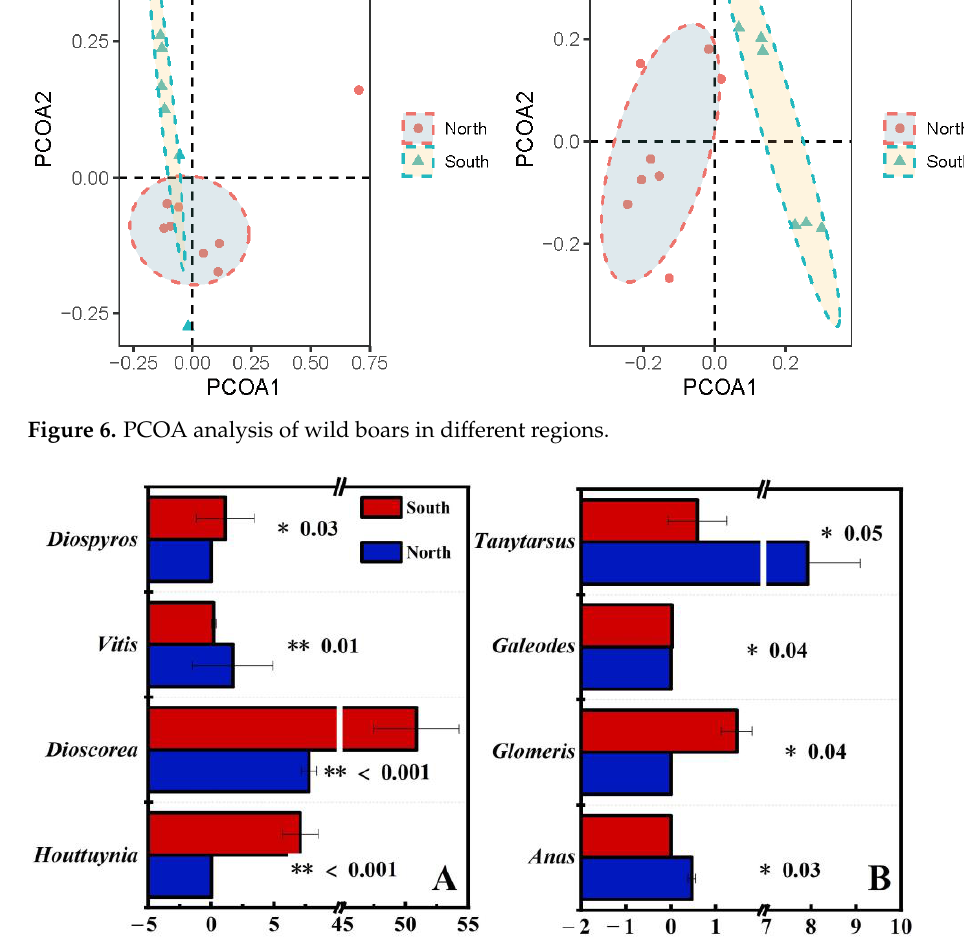
Figure 7. Comparison of relative abundances at the genus level between northern and southern wild boars regarding ( A ) plant food sources and ( B ) animal food sources. * represents a significant difference p < 0.05 and ** represents a significant difference p <